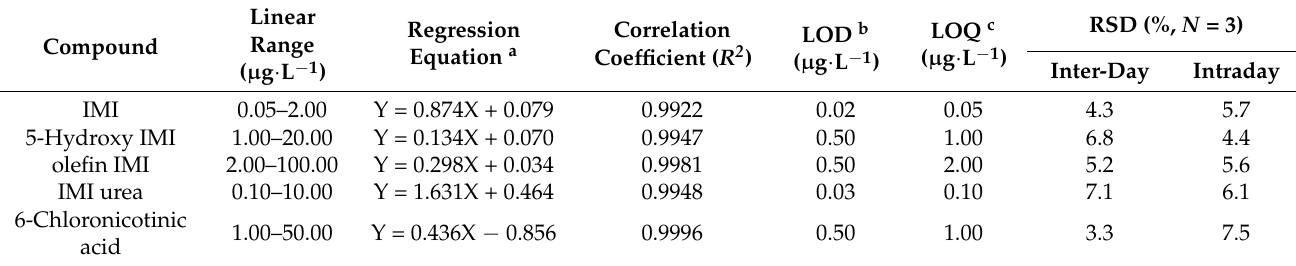
Table 1. Analytical performance for imidacloprid and its metabolites in solution.